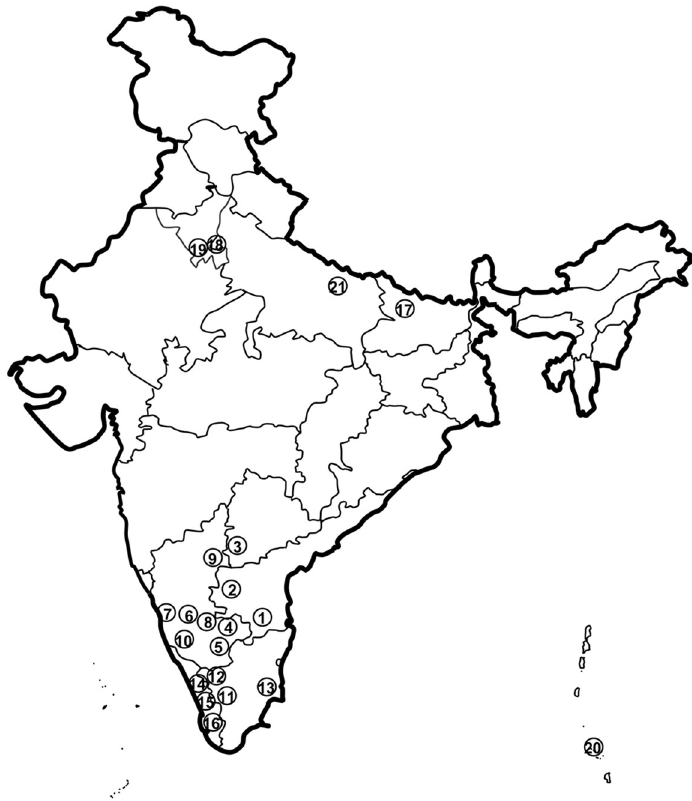
Fig 1. Details of samples collected from different locations of India used for the present